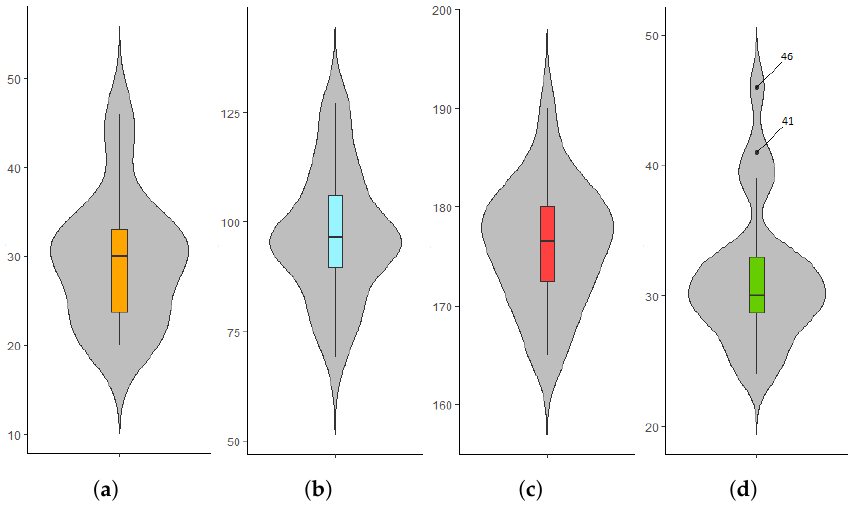
Figure 3. Boxplots to display the distribution of volunteers’ age, weight, height, and BMI in our dataset. ( a ) Age (years). ( b ) Weight (kg). ( c ) Height (cm). ( d ) BMI (kg/m 2